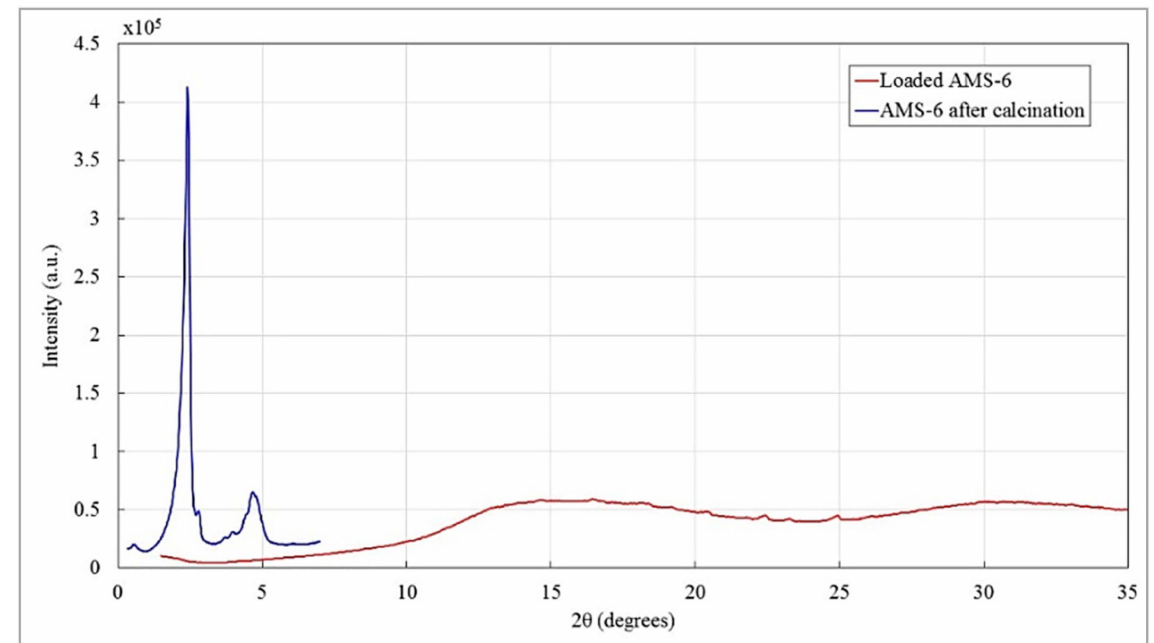
Figure A16. X-ray diffraction (XRD) pattern of pure calcined AMS-6 mesoporous nanoparticles (blue) and the loaded AMS-6-Dox nanoparticles (red). The measurements of the pure calcined AMS-6 NPs reveal a highly ordered mesostructured with peaks of scatter in-between the pores of the nanoparticles. The typical XRD pattern of the pure sample display peaks at low angles of 2.4 ◦ and 4.8 ◦ with an intensity of 4.12 × 10 5 and 0.6 × 10 5 a.u., respectively. The loaded AMS-6-Dox sample curve shows small peaks at high angles of approximately 15 ◦ and 30 ◦ with intensities below 0.75 × 10 5 a.u., which are most likely the scattering patterns of crystallized Dox outside of the pores. The pores of the AMS-6-Dox still seem to be filled with DOX, since the pattern does not show any peaks at low angles, which would indicate scatterings between the pore walls of the nanoparticles.